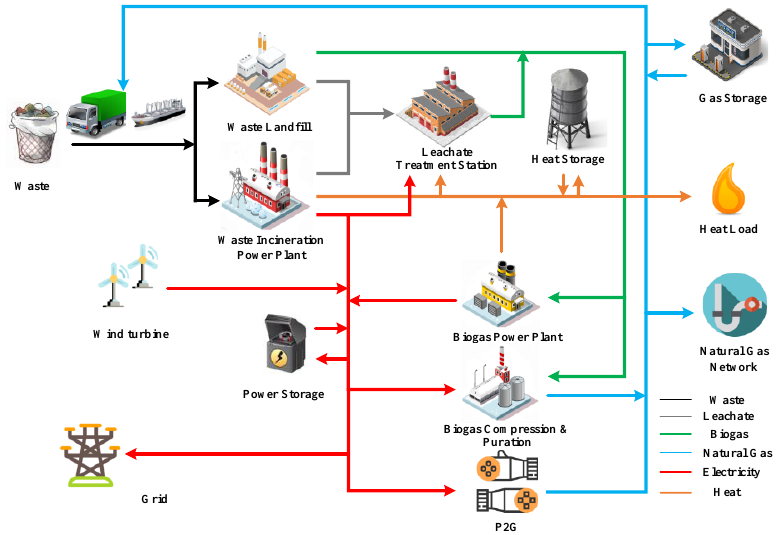
Figure 5. Physical planning topology of a multi-energy circular system (MECS) coupled with WPB.